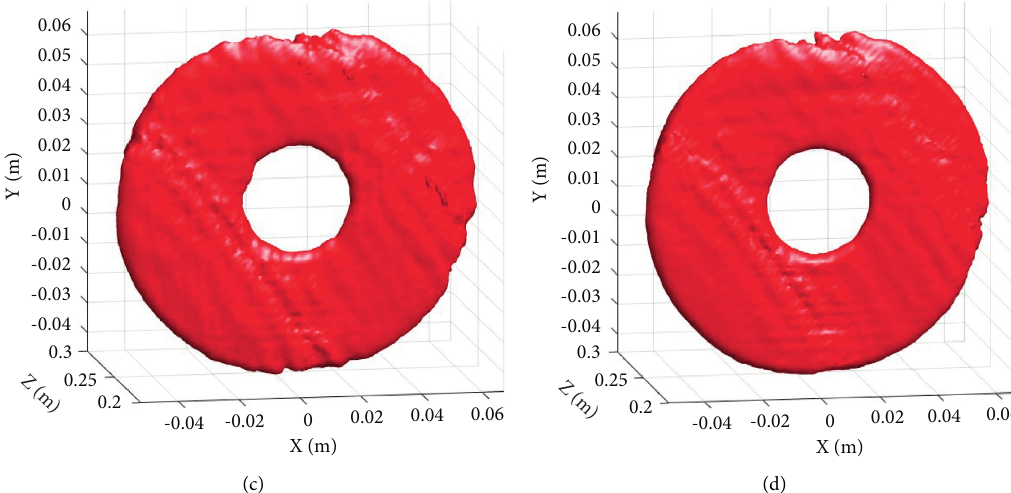
Figure 8: Reconstructed 3D images of disc with the presented algorithm under different data sparsity rates: (a) 10%; (b) 20%; (c) 30%; (d) 50%.